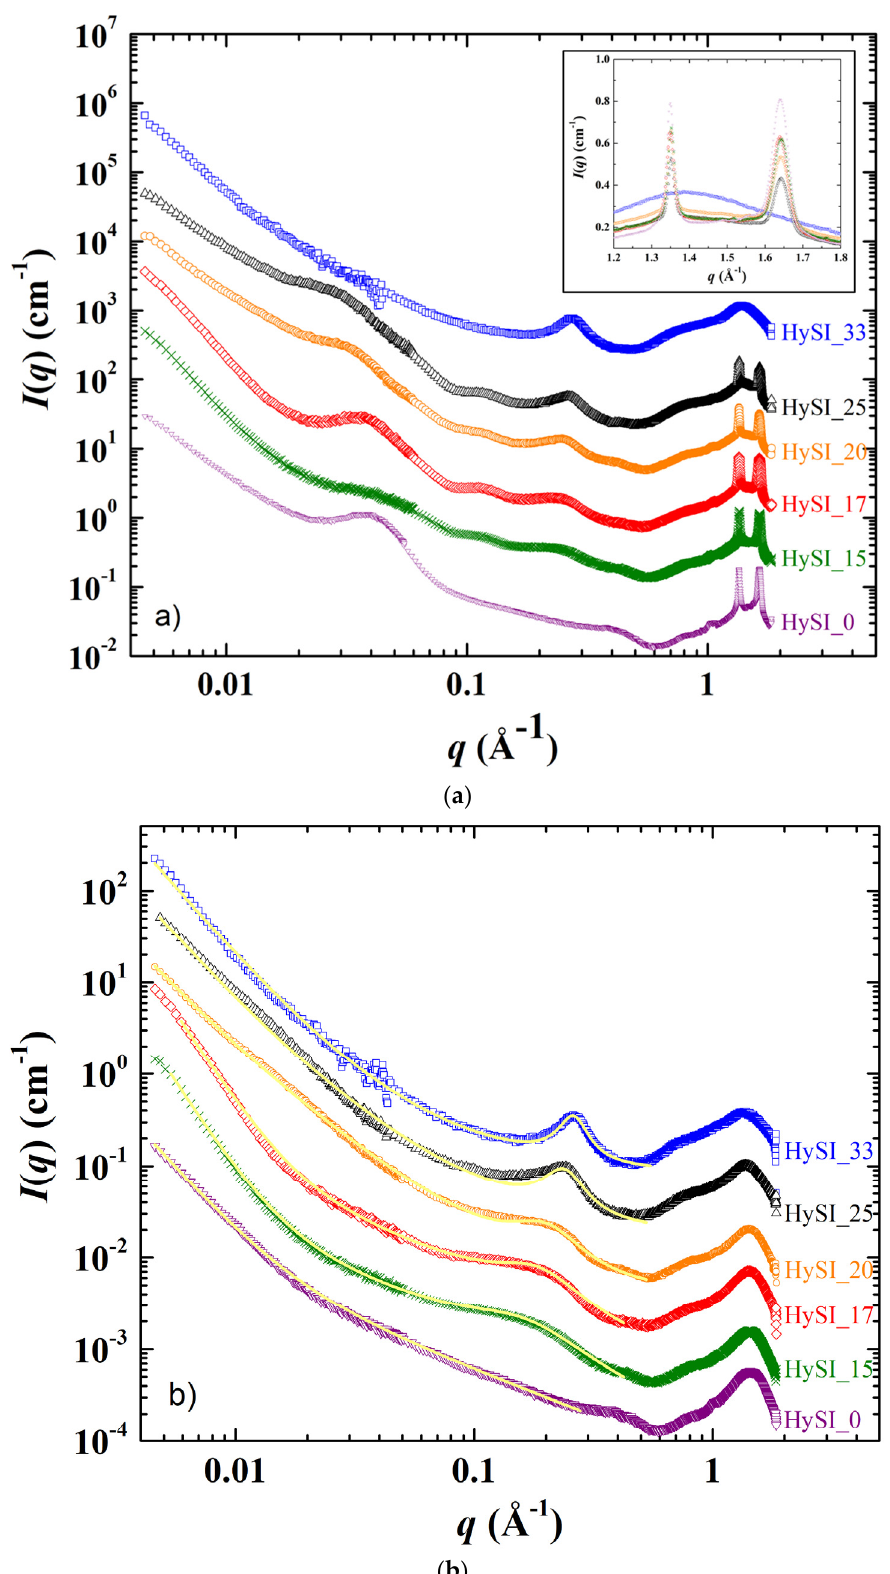
Figure 5. SAXS/WAXS scattering curves recorded at ( a ) 25 °C and ( b ) 60 °C for the HySI_ w VSTFSILi electrolytes with w VSTFSILi of ( ▽ ) 0, ( × ) 15, ( 3 ) 17, ( # ) 20, ( △ ) 25, and ( □ ) 33. The curves are shifted in intensity for clarity. The inset in figure a) is a magnification in the high q range. The yellow con- tinuous lines in figure ( b ) are the fit curves from the ad hoc model (see main text). As the HySI_33 sample is the only one that does not crystallize at 25 °C (see Figure 3b), the absence of the diffraction peaks (at q* = 1.35 and 1.64 Å − 1 ) and correlation peaks at features come from the PEO crystalline structure. Indeed, they completely disappear when the electrolytes are heated at 60 °C, i.e., above their melting temperature (Figure 5b). The crystalline peaks correspond to distances in the crystallized PEO of 4.65 Å and 3.8 Å [34]. The large correlation peak at ~0.035 Å − 1 and the other correlation peaks at intermedi- ate q originate from the lamellar stacking of the crystallized PEO; the main peak being the first order peak and the other ones its harmonics. The exact positions of such peaks are difficult to precisely determine as they are superimposed with the overall scattering decay at law q , which varies from one sample to another, and with the broadening of correlation peak at 0.26 Å − 1 . Nevertheless, the distance between lamella is estimated to be about ~180 Å (2 π /0.035). In addition, the intensity of the crystalline peaks decreases with increasing salt content. They are similar for HySI_15 and HySI_17 and progressively broaden for HySI_20 and HySI_25 (see inset of Figure 5a). The crystalline peak intensity is highest for the sample without salt which means that the presence of salt reduces the PEO crystallin- ity. This result is in accordance with the decrease of the degree of crystallinity χ c with w VSTFSILi calculated from DSC (see Figure 4b). The data at 60 °C (Figure 5b) enable the identification of the structural features that are not associated with the PEO crystalline parts, namely a scattering decay at the lowest q following a power law ranging between q − 3 and q − 4 (for q < ~0.04 Å − 1 ), another scattering decay with a much smaller lower power law ( q − 1.7 − q − 1 ) at intermediate q , and the correla- tion peak at ~0.26 Å − 1 . The scattering decay at the lowest q comes from some fluctua- tions/heterogeneities of the electron-scattering length density within the samples. It is dif- ficult to assess their exact origin as the samples contain three types of scatterers: PEO